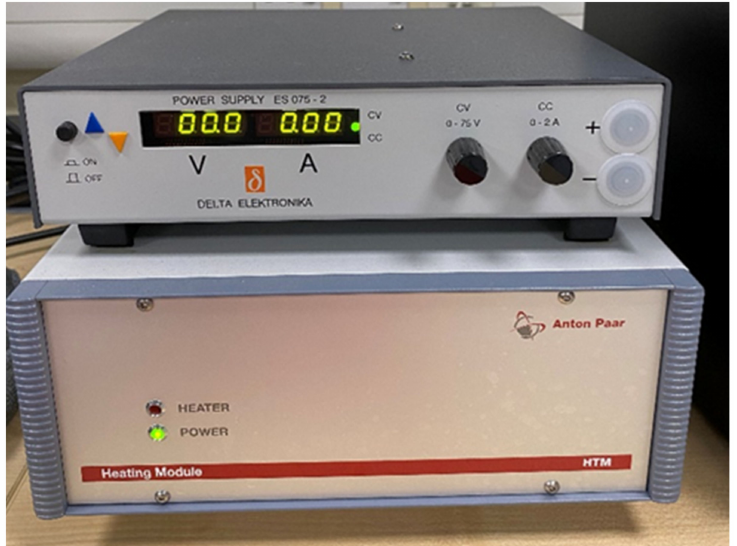
Figure 4. Tribometer heating